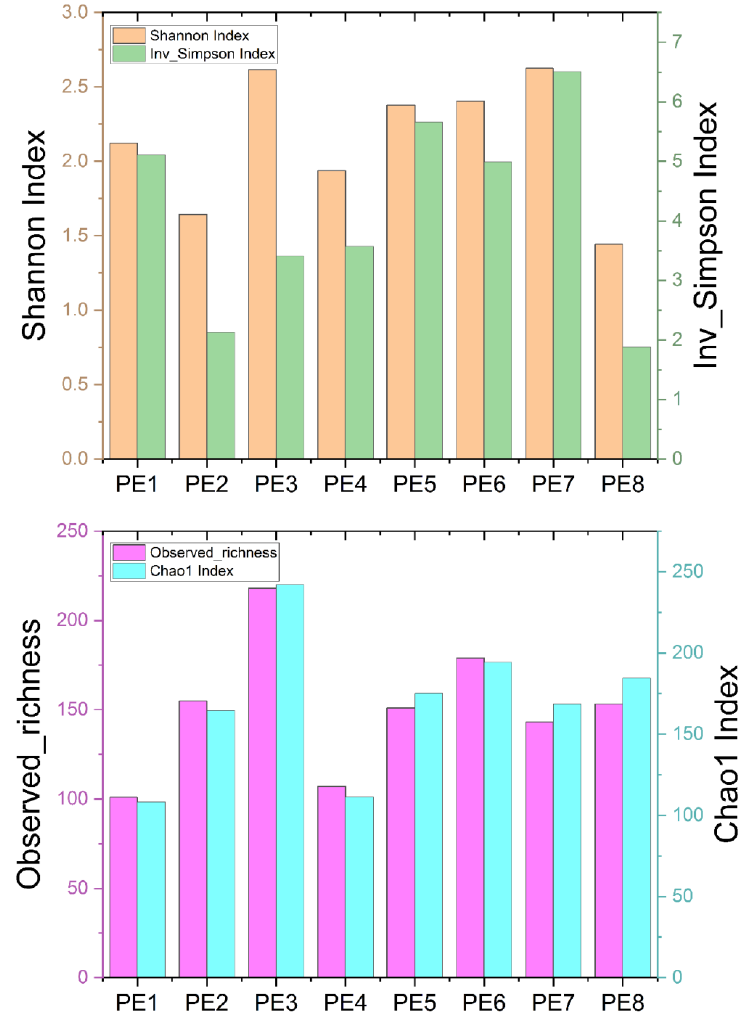
Figure 1. Four α -diversity indices — Shannon index, Inverse Simpson index, observed richness, and Chao1 index — of the eight fecal specimens from eight stranded melon-headed whales (PE1-8). The results are based on the ASV datasets.